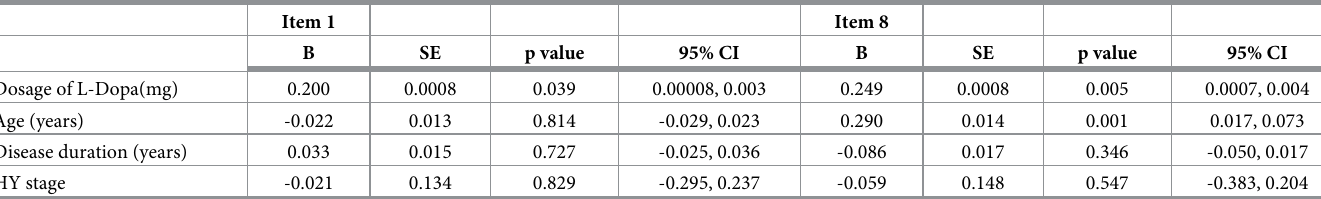
Table 2. Multiple regression analysis to identify predictors for the item 1 and 8 scores.